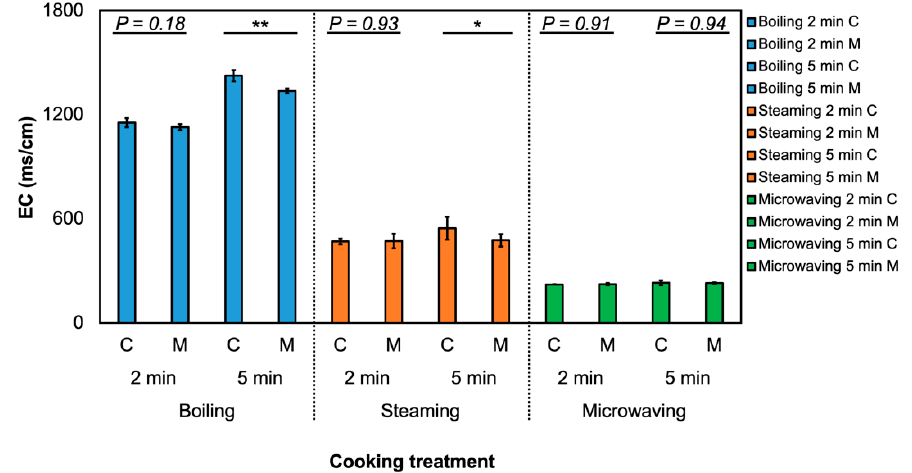
Figure 2. Electrical conductivity in cooking water. Asterisk (*) indicates significant difference with or without MeJA within the same cooking treatment by Student’s T-test ( p ≤ 0.05, n = 3) ns , *, p ≤ 0.05; **, p ≤ 0.01. The first letter, C or M, indicates the control or methyl jasmonate-treated group. The second letter, B, M, or S, indicates different cooking treatments including boiling, microwaving, and steaming. The last number after the B, M, or S indicates the duration of the cooking method (mins).